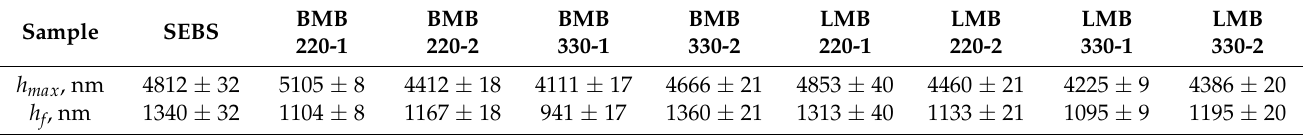
Table 4. The residual depth after final unloading ( h f ) for SEBS and SEBS/HNT-QM masterbatches. Sample